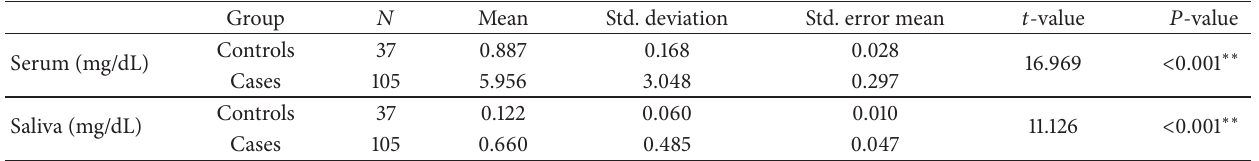
Table 1: Comparison of serum and salivary creatinine levels between CKD patients and controls using 𝑡 test.